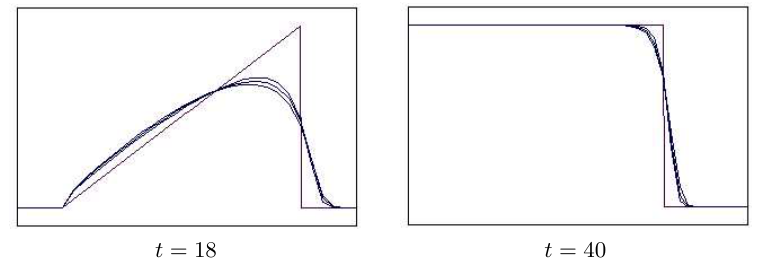
Figure 2. Numerical solution obtained using the implicit upwind scheme for 2 initial data